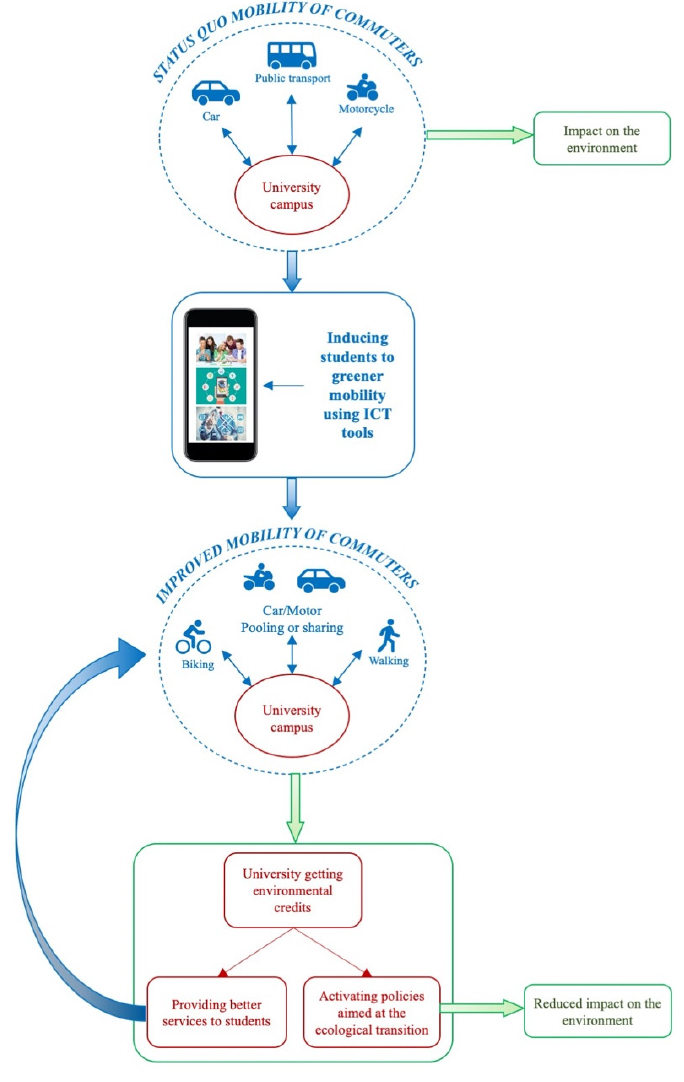
Figure 1. Visual sketch of the win-win proposal for the mobility of the commuter students.